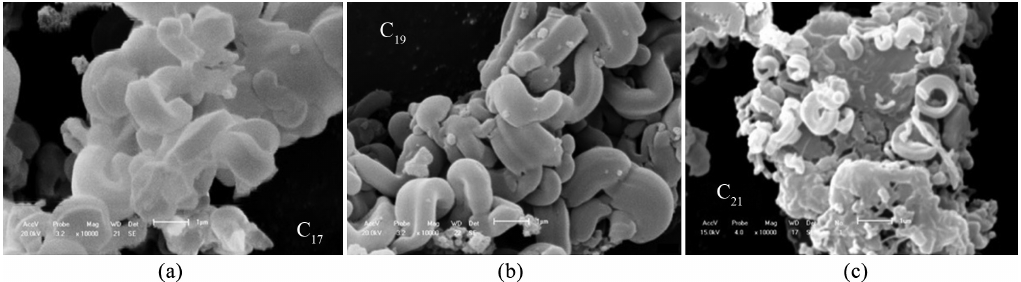
, C , C , C C , C C , C C and C 17 19 21 17 19 17 21 19 21